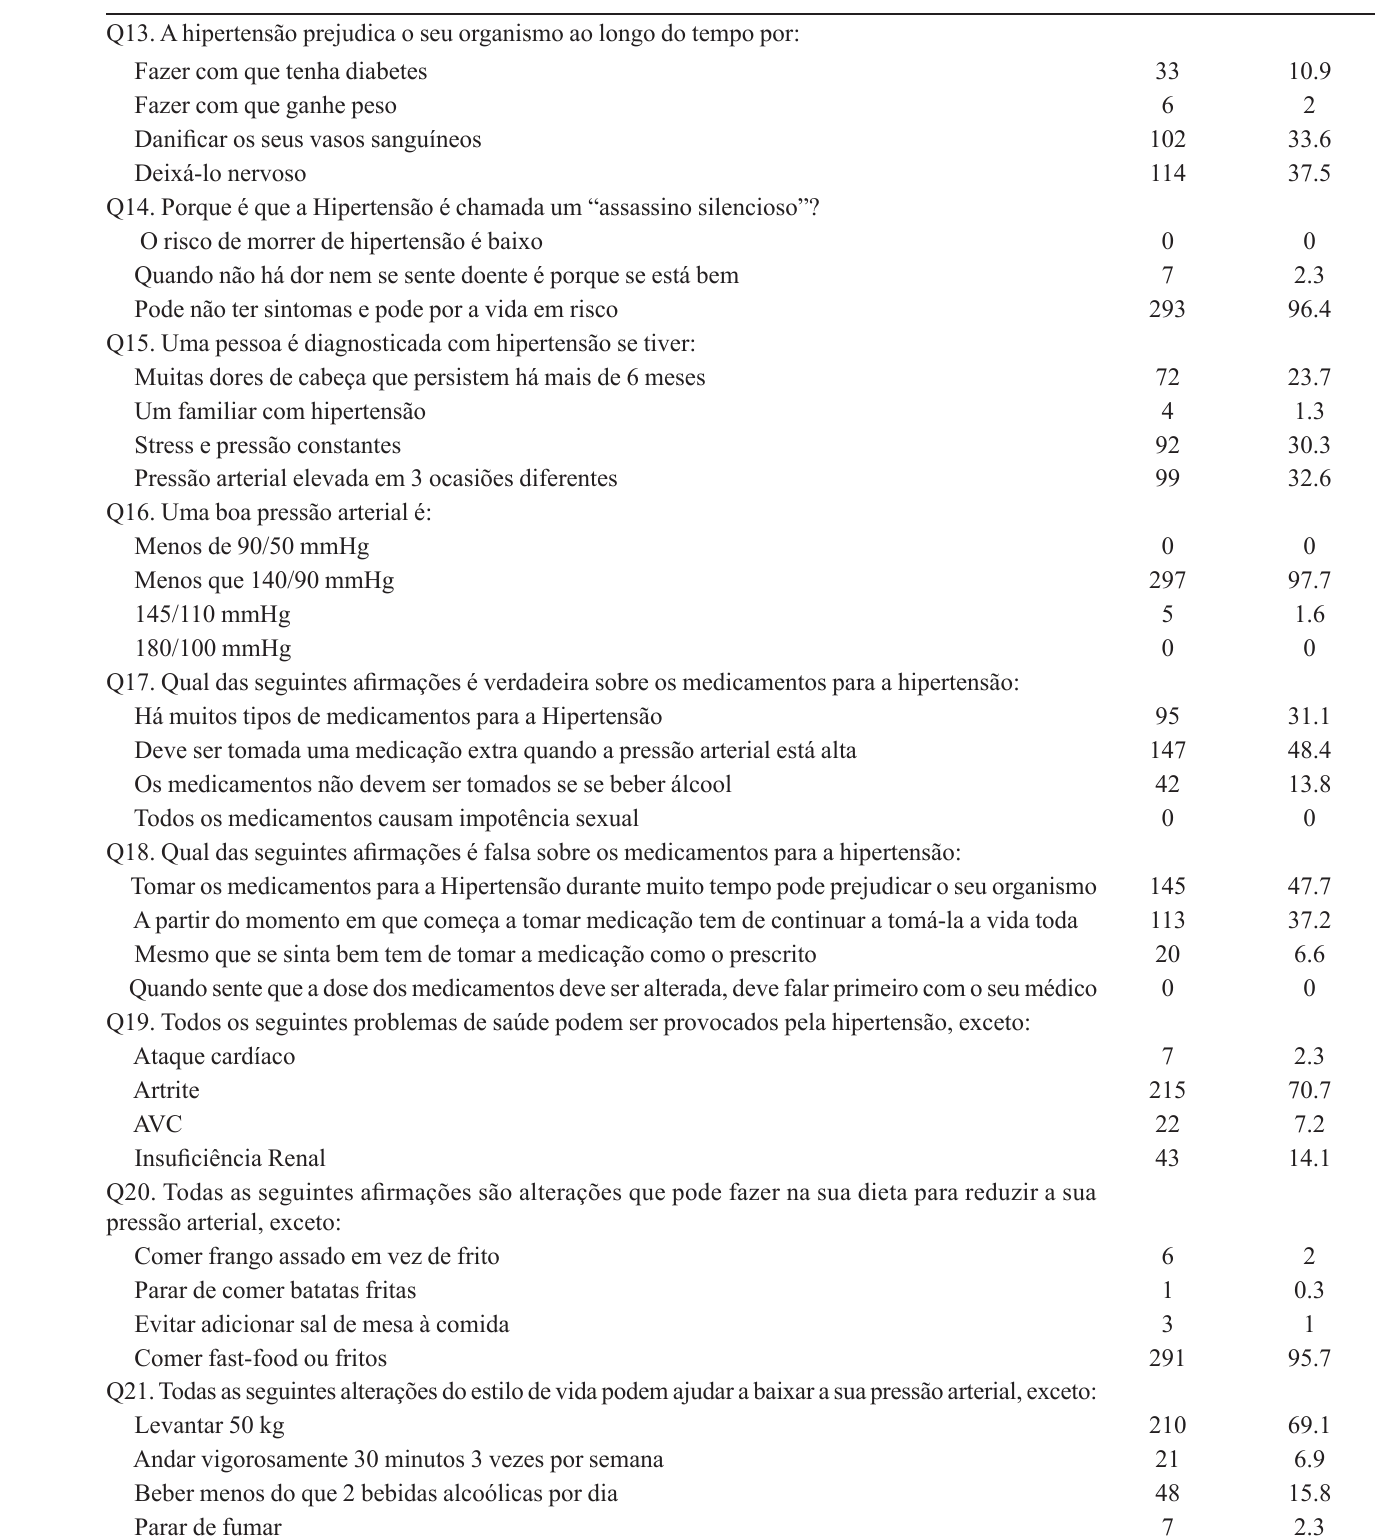
TABLE II - Frequencies of answers of multiple choices